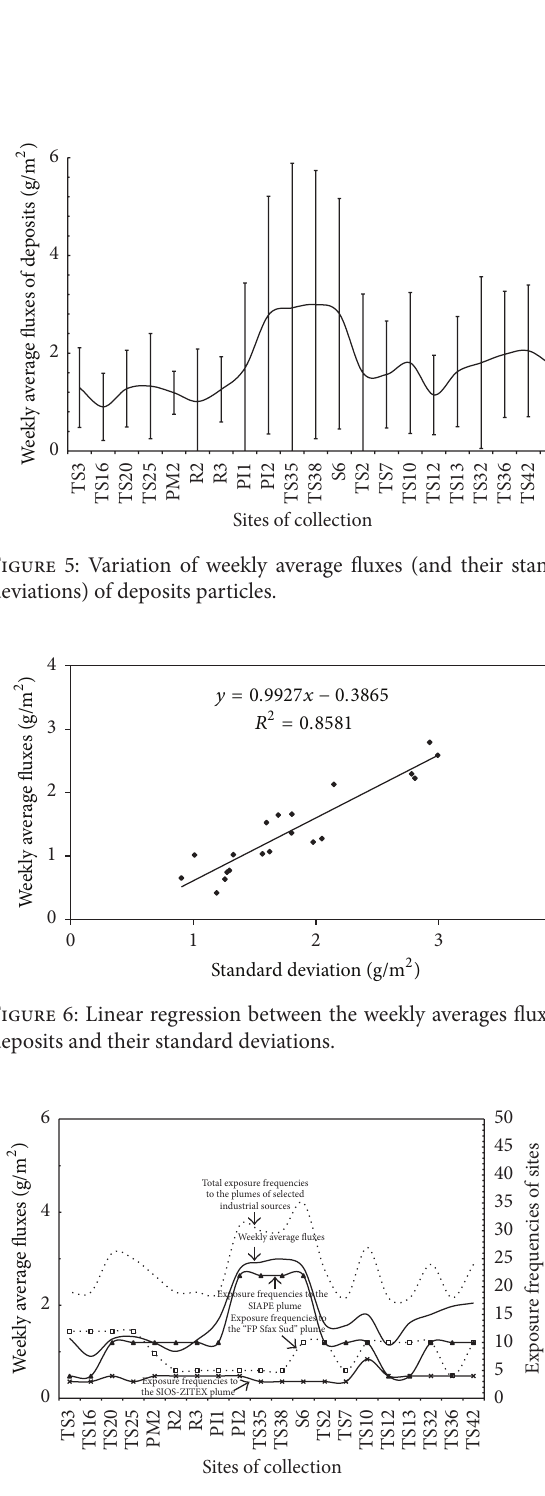
Figure 7: Spatial variation of weekly average fluxes of deposits and frequencies of exposures to the industrial